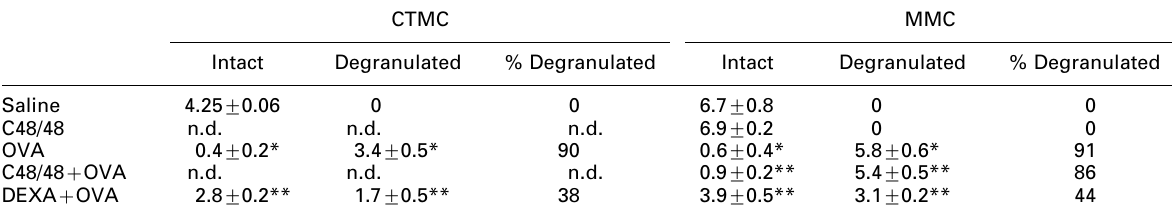
Table 1. Cumulative data for mast cell numbers in rat proximal